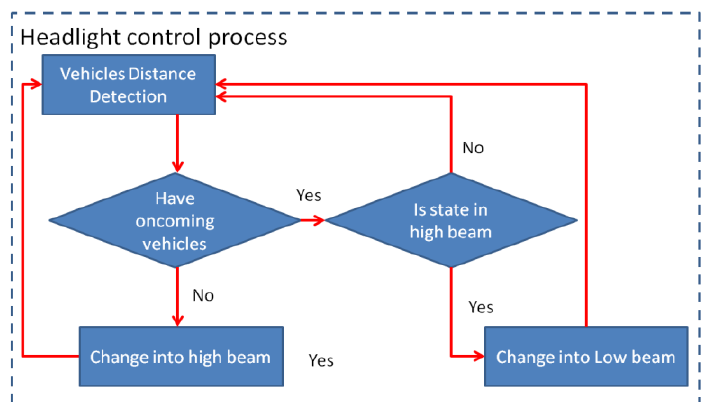
Figure 7. Headlight control process work